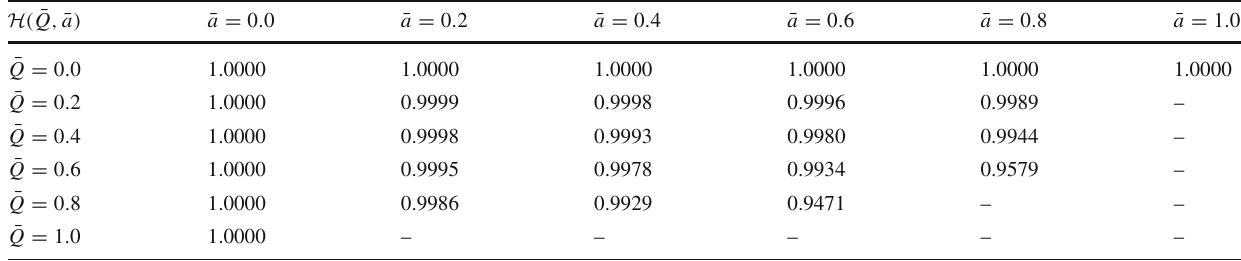
Eqs. (6) and (10)]. Interestingly, the dimensionless ratio H ( ¯ Q , ¯ a ) is foundtobeamonotonicallydecreasingfunctionoftheblack-holephys- ical parameters ¯ a and ¯ Q . In particular, one finds that charged and spin- ning Kerr–Newman black holes are characterized by the sub -critical mass-to-circumference ratio H ( ¯ Q (cid:9)= 0 , ¯ a (cid:9)= 0 ) ≡ 4 π M / C eq < 1